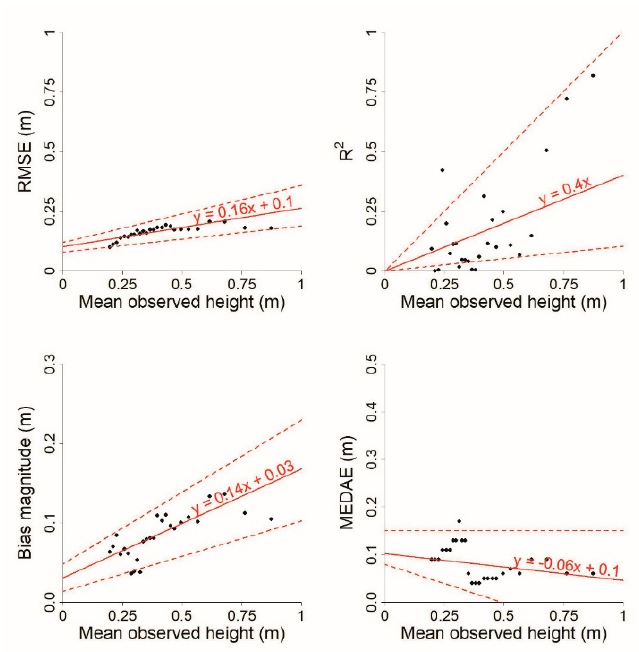
Figure 7. Trends in RMSE, magnitude of bias, median absolute error (MEDAE), and R 2 as a function of mean seedling height for the best result (0.35 cm GSD, leaf-off, DIPC TIN ). Each point represents a subset of 15 seedlings ordered in ascending order by reference height. Each pair of consecutive points along the x axis shares 13 seedlings. The solid red line is the Theil–Sen regression line, and the dashed lines represent the lower and upper 95% confidence intervals.